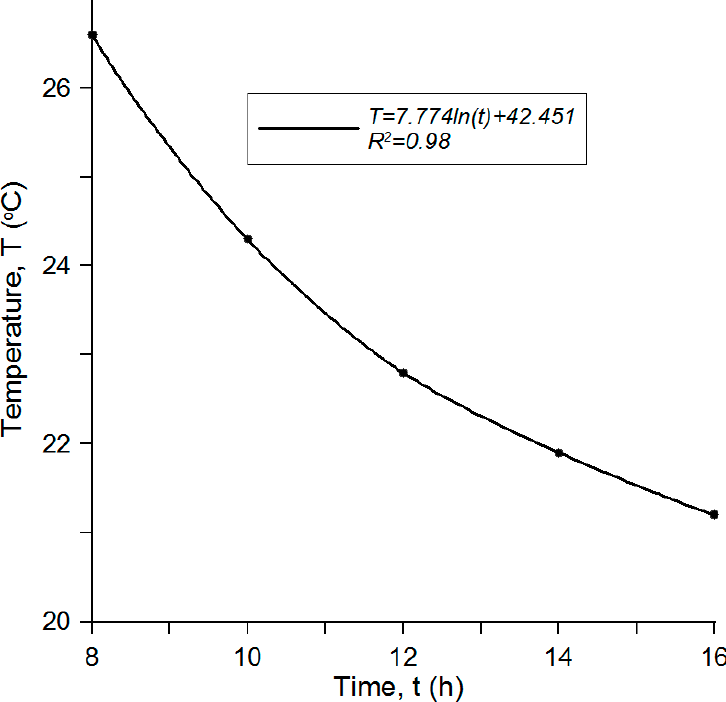
Figure 5. Dynamics of soil temperature decrease with time.